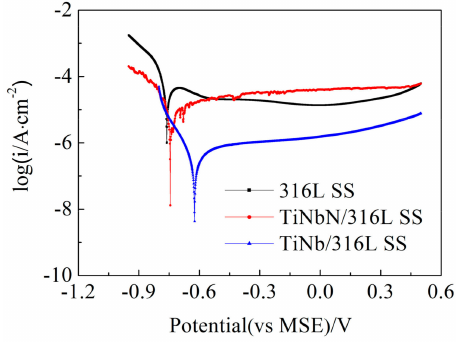
Figure 6. Potentiodynamic polarization curves of 316L SS, TiNb/316L SS, and TiNbN/316L SS.